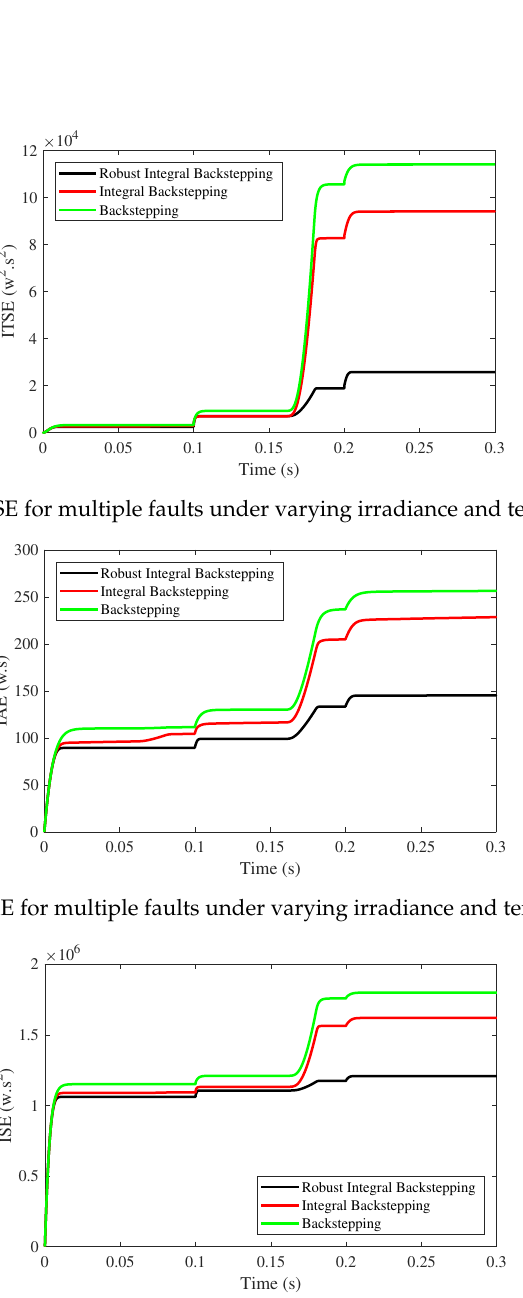
Figure 19. ISE for multiple faults under varying irradiance and